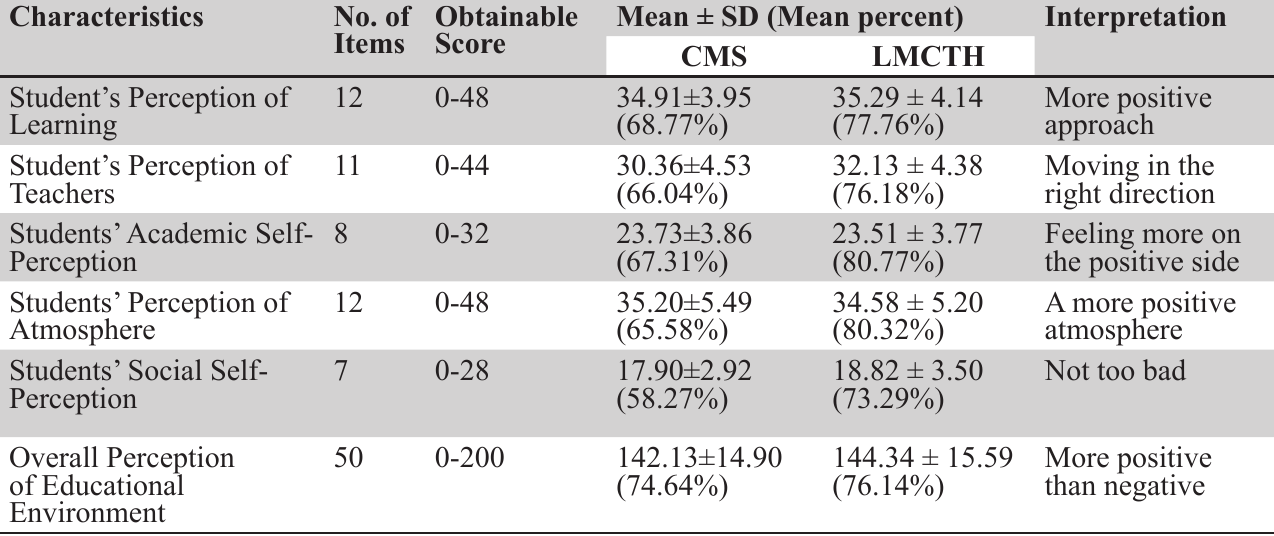
Table 2. Scores of Overall Perception of Educational Environment and its subscales using Dundee Ready Educational Environment Measure (DREEM) (N=190) Characteristics